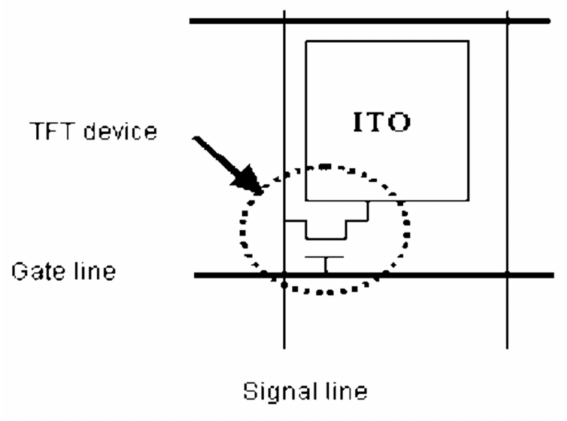
Figure 5. The structure of a TFT-LCD